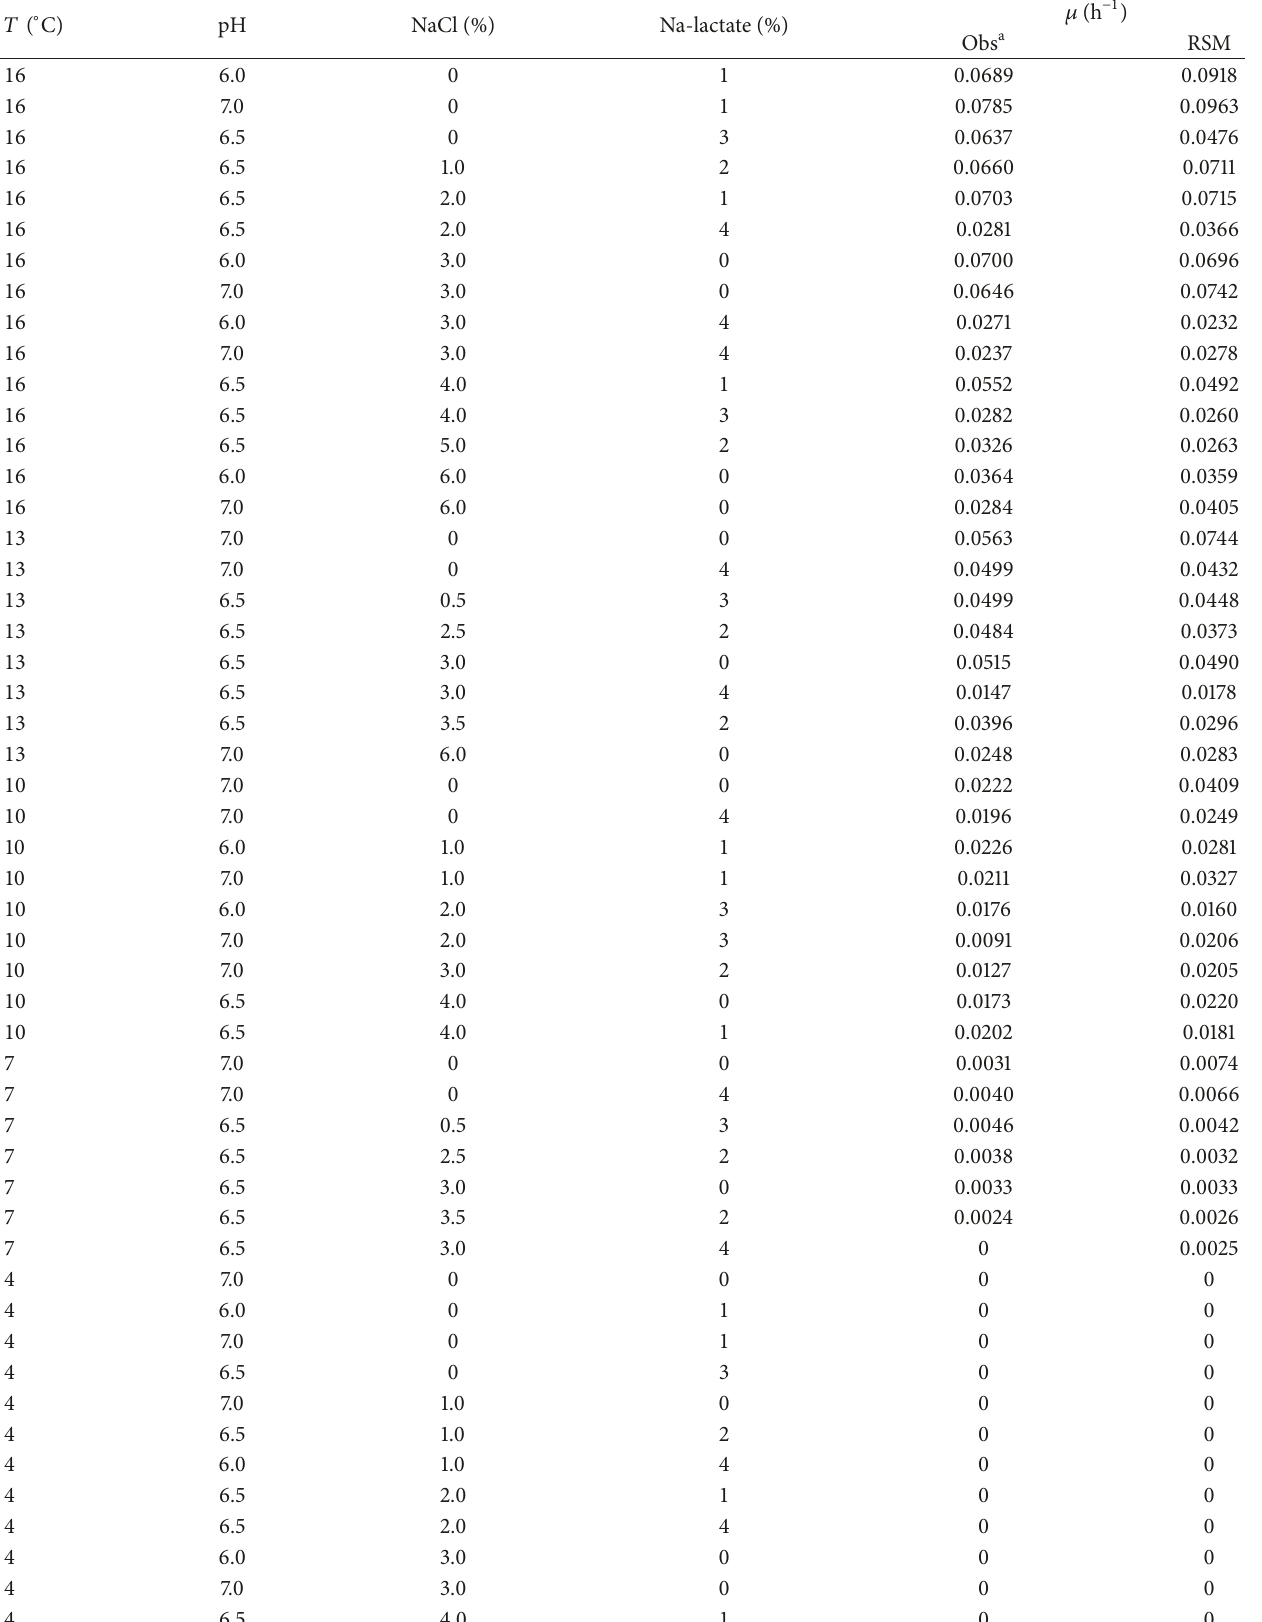
Table 2: Observed (Obs) and predicted growth rate ( 𝜇 , h −1 ) by response surface model (RSM) of 𝐿. 𝑝𝑙𝑎𝑛𝑡𝑎𝑟𝑢𝑚 for mathematical